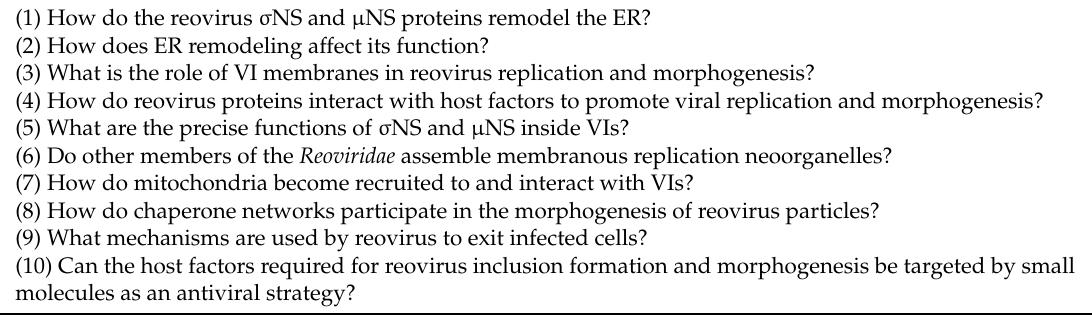
Table 1. Key unanswered questions in studies of reovirus replication organelles. ER—endoplasmic reticulum; VI—viral